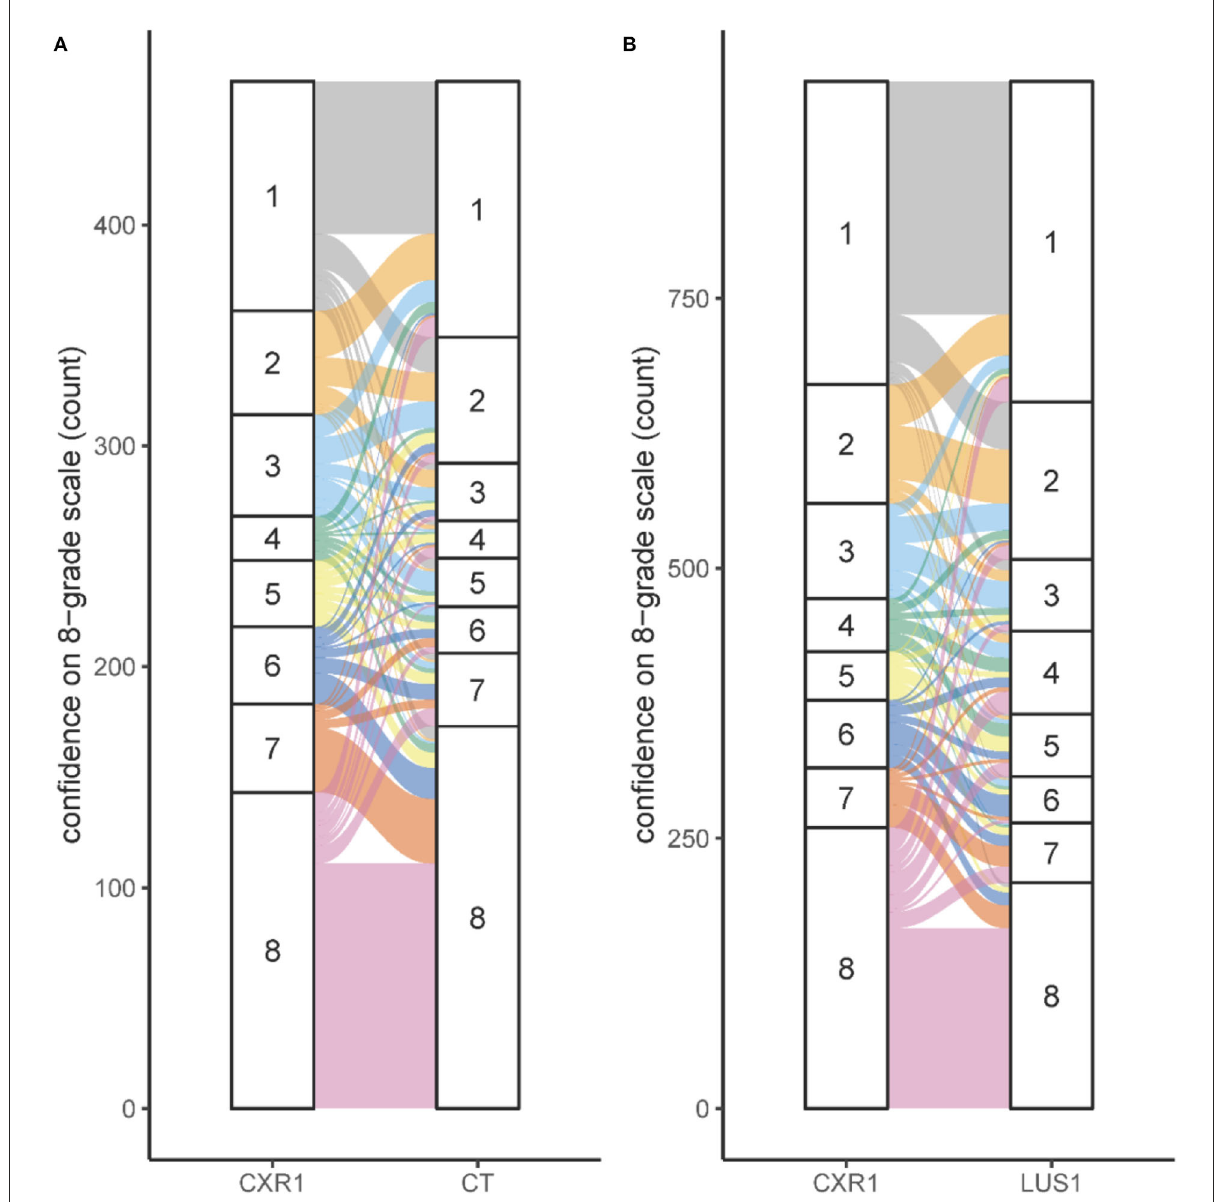
FIGURE2 Confidence for several imaging modalities. (A) Shift in scoring on the 8-grade confidence scale for the situation CXR1 to CT. (B) Shift in scoring on the 8-grade confidence scale for the situation CXR1 to LUS1. The confidence on the 8-grade scale corresponds to the confidence of the ARDS diagnosis, ranging from high confidence no ARDS (grade 1) to high confidence ARDS on both extremes (grade 8), see Figure